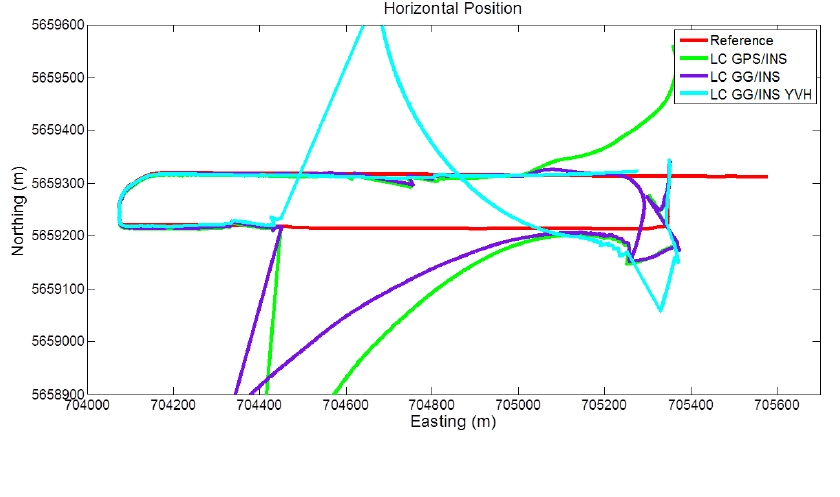
Figure 11. Trajectories obtained with the loose coupling approach (Segment 2).